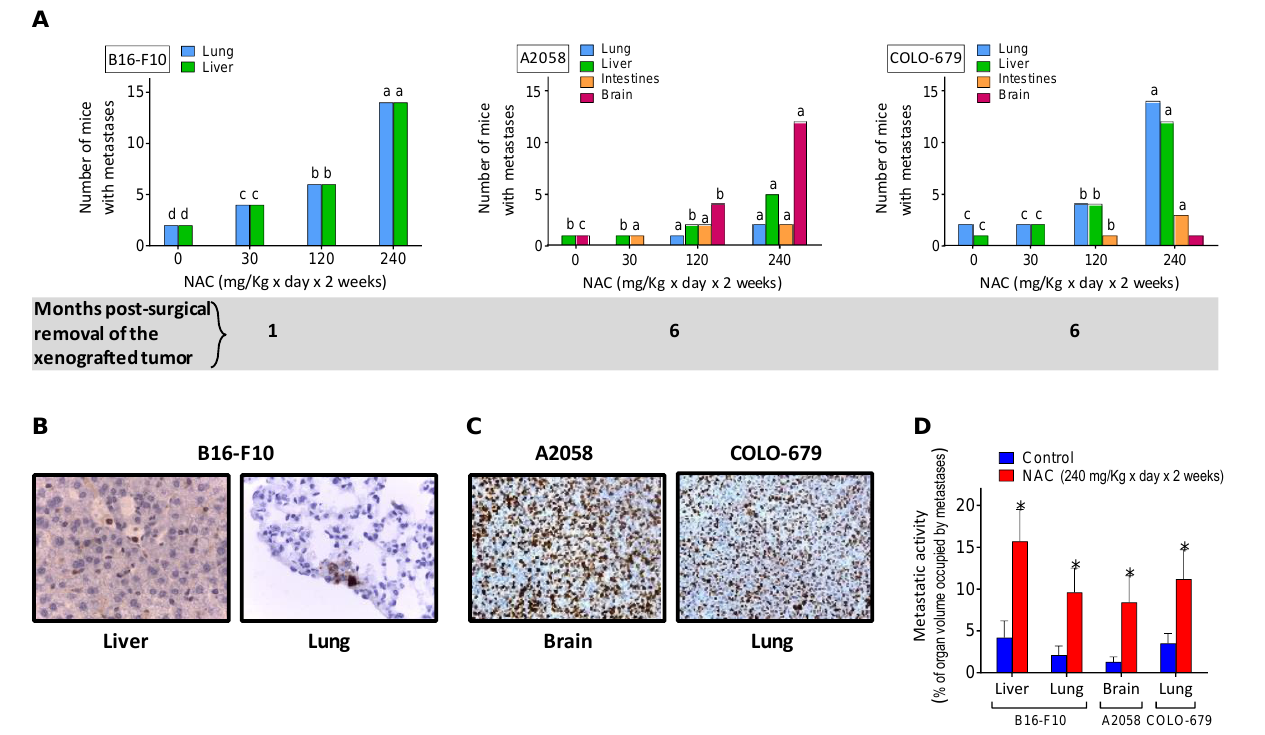
Figure 2. NAC administration promotes metastatic spread in murine and human melanomas. In- dependently of the dose, NAC was administered as indicated in Figure 1B. All melanoma cell lines described in this Figure were inoculated intradermally (on the back) with 2 × 10 6 melanoma cells per mouse as indicated in the Materials and Methods section. Melanoma xenografts were surgically removed on days 30 (A2058 and COLO-679), 60 (SK-Mel-28), and 20 (B16-F10) post-inoculation. Mice were sacrificed at 6 months (human melanomas) or 1 month (B16-B10), after removal of the primary tumor. The presence of metastatic foci was investigated in four different organs, which are classical sites for melanoma metastases. ( A ) Number of mice (n = 20 in each group) where growing metastases were found. No metastases were found in mice that were initially inoculated with the SK-Mel-28 melanoma. A one-way analysis of variance (ANOVA) was used to make comparisons among the different treatment groups. Different superscript letters indicate differences for each organ where metastases where found, p < 0.05. ( B ) Microscopic images showing B16-F10 melanoma cells found in the liver and lung (immunochemical detection using S100 monoclonal antibodies) of mice pretreated with NAC. ( C ) Cell proliferation in metastases (A2058 in the brain and COLO-679 in the lung of mice pretreated with NAC) using anti-Ki-67 monoclonal antibodies. ( D ) The per- centage of organ volume occupied by metastases ( A ) was analyzed following the methodology in- dicated under Materials and Methods. * Significantly different p < 0.01, comparing NAC (240 mg/Kg × day × 2 weeks)-treated mice versus untreated controls.